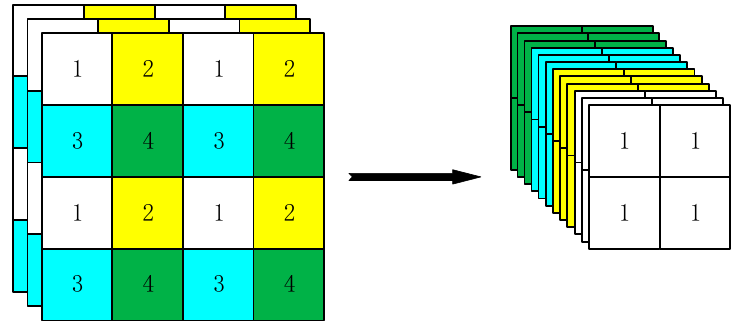
Figure 4. Slicing operation.